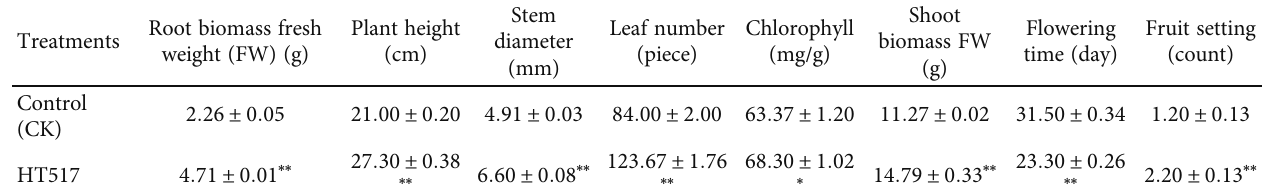
Table 1: E ff ects of Bacillus megaterium on tomato growth and development.